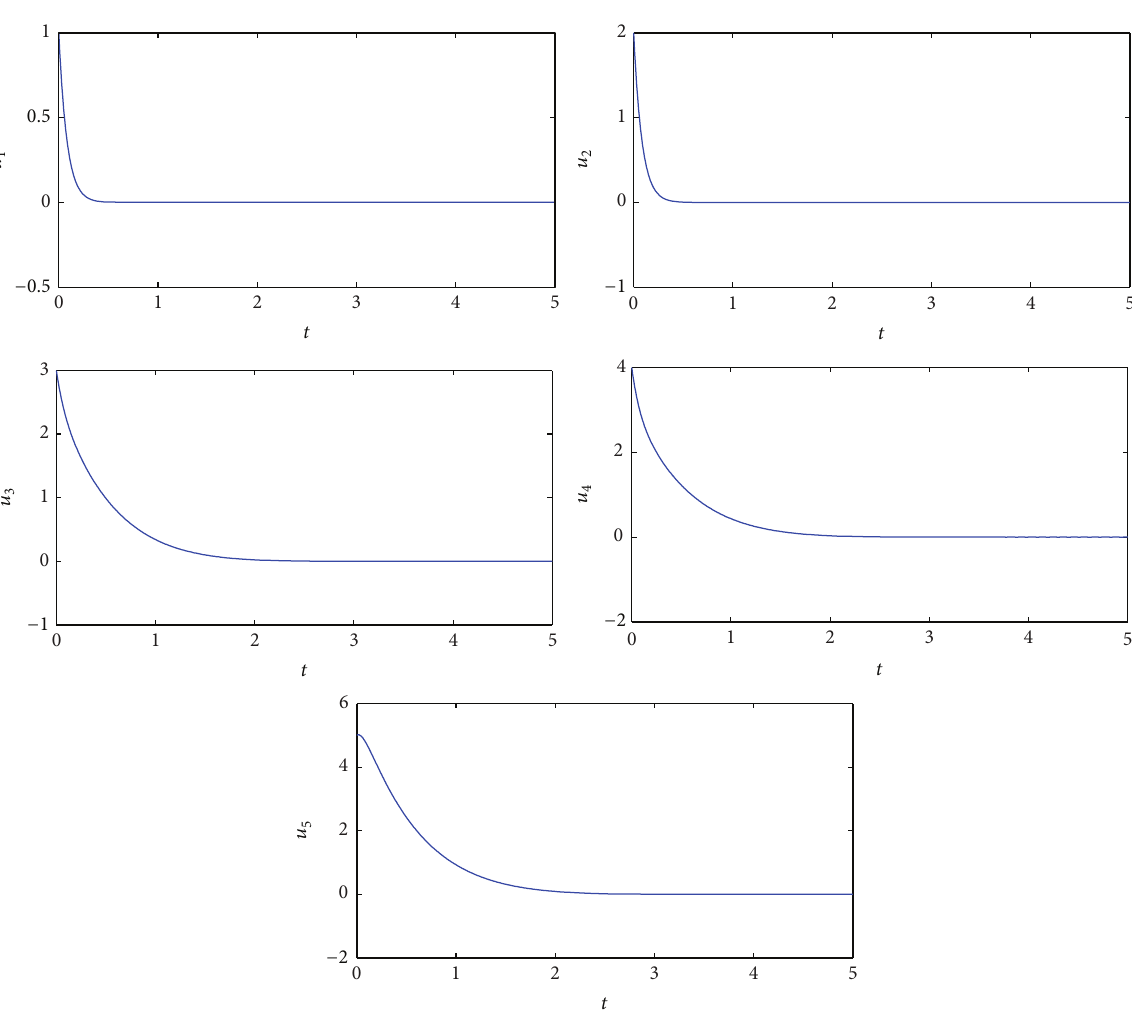
Figure 1: The states of the controlled system (11) with controllers